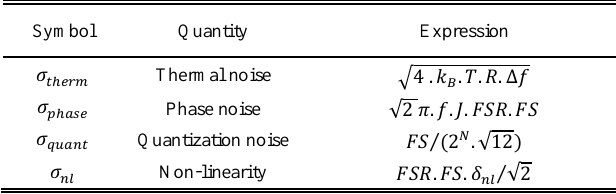
Fig. 3. Effective Number of Bits (ENOB) for every vertical sensitivity measured on a Keysight DSO91204 up to 20 MHz (up) and computed up to 4 GHz according to the previous model